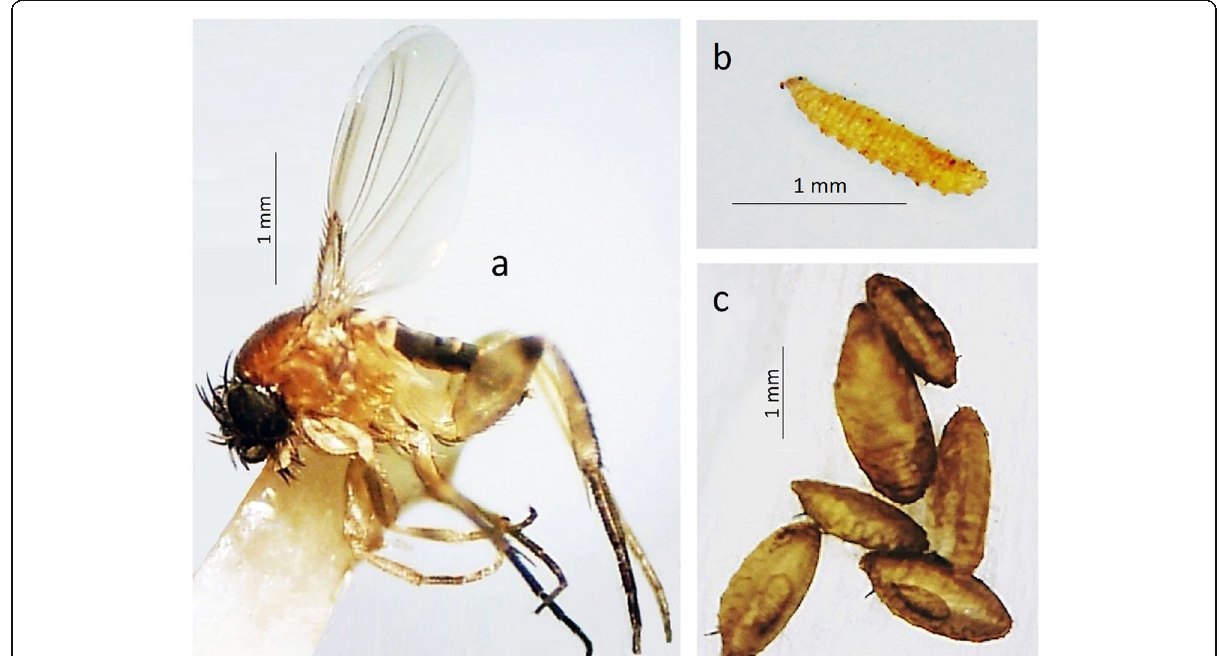
Fig. 1 Megaselia scalaris (Loew). a Adult female, lateral view. b First larval instar. c